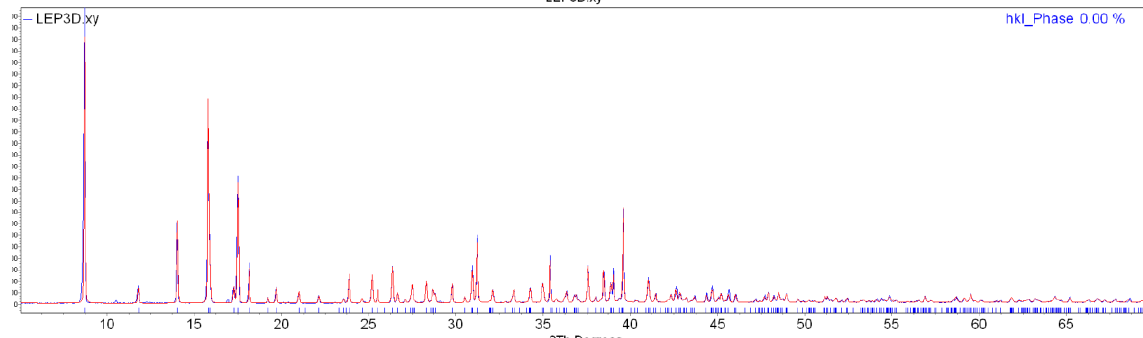
Fig. S2. LeBail fit of [Cu CSD (refcode AFMPCB), unit cell parameters as follows: a=10.190(1) Å, b=11.134(1) Å, c=7.675(1) Å β = , space group P 2 Chim. Miner. 1979, 16, 124. Calc. for C 35.21; H, 2.91; N,